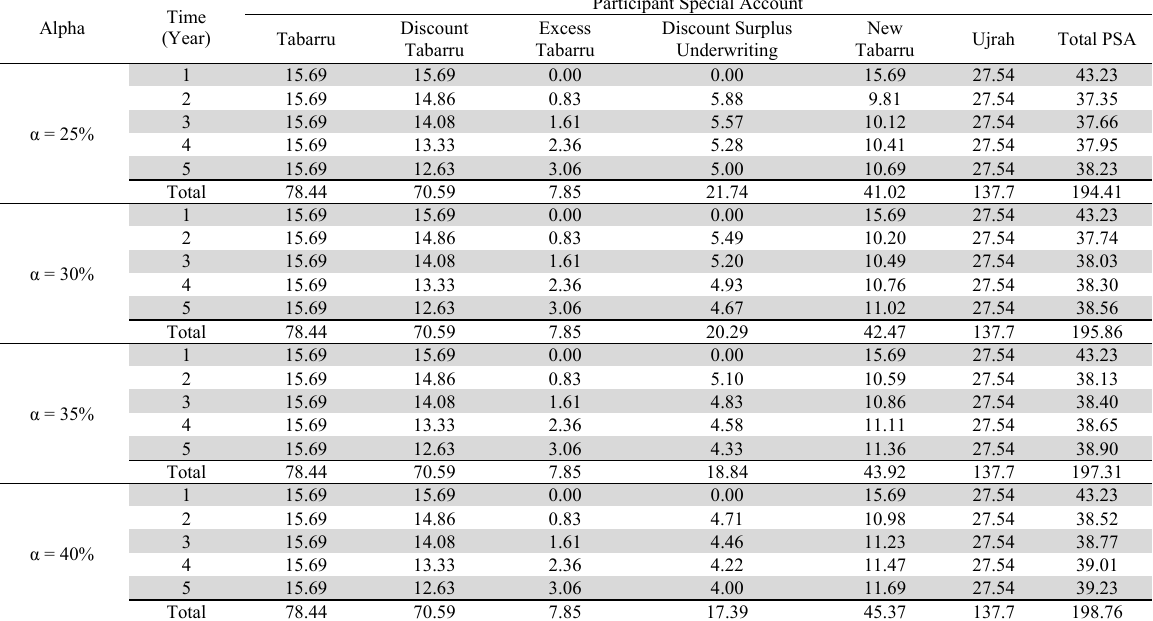
The value of participant special accounts at the inception of insurance under equity-linked policy